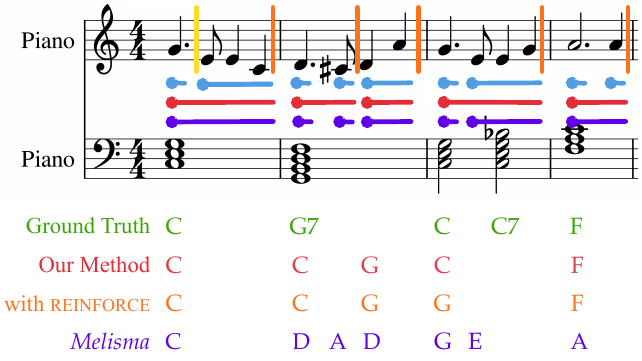
Figure 11. A sample from “Auld Lang Syne” processed by our model and Melisma in C major key.